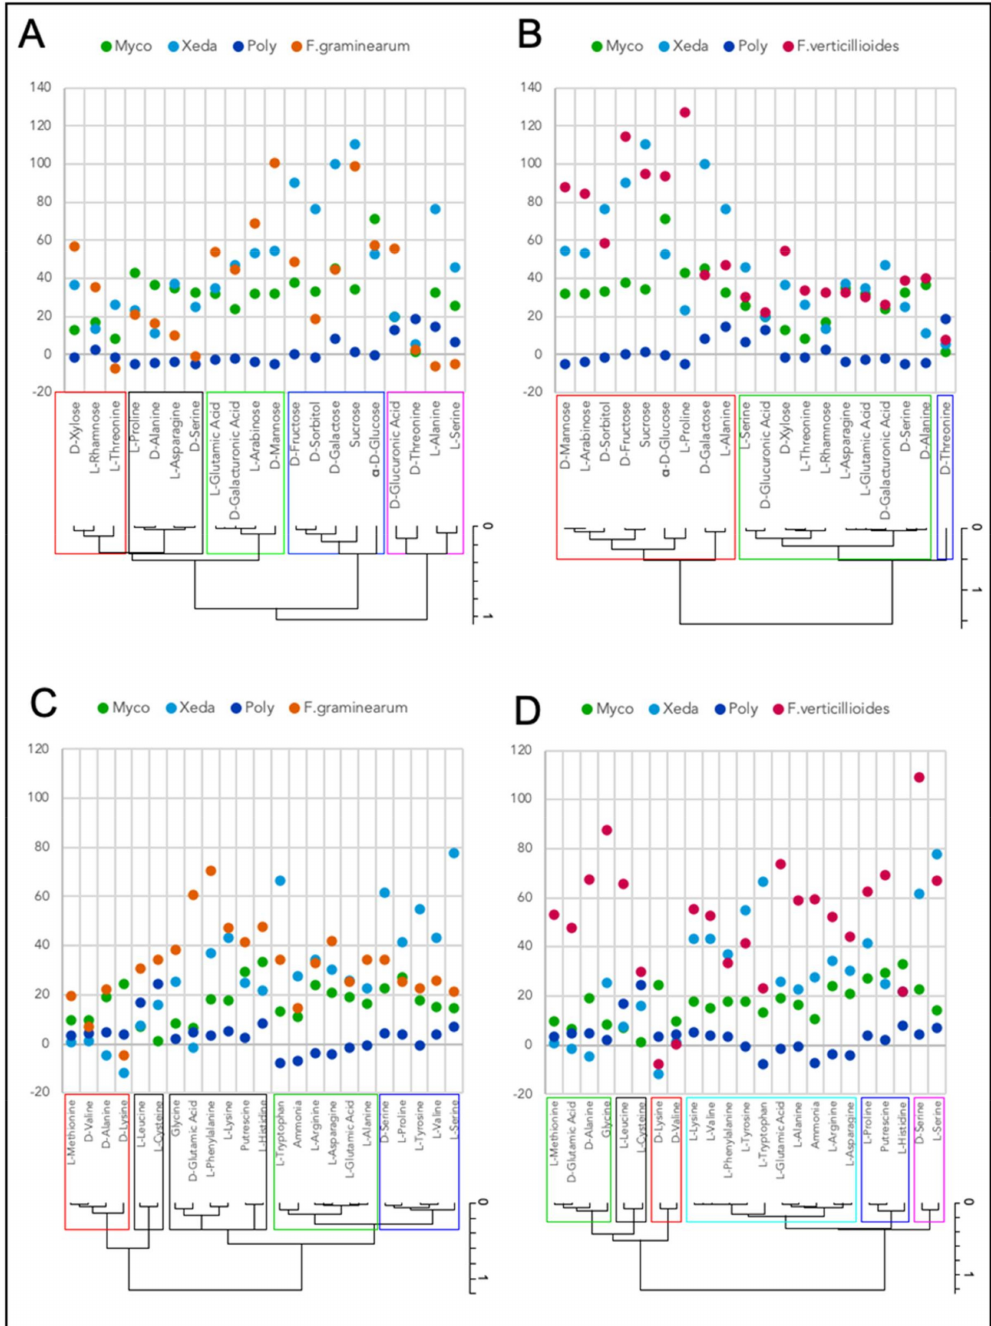
Figure 9. Nutritional profiling of BCAs and Fusaria pathogens for cereal compounds (carbon or nitrogen sources). ( A , B ) F. graminearum and F. verticillioides , respectively, vs. all BCAs (Myco, Xeda and Poly) for carbon compounds; ( C , D ) F. graminearum and F. verticillioides , respectively, vs. all BCAs (Myco, Xeda and Poly) for nitrogen compounds. Both panels show optical density measurements over a 138h time course at 25 ◦ C in phenotype micro-arrays (area under growth curve). Major elements found in cereals (wheat and maize for F. graminearum and F. verticillioides , respectively) are available in literature [30–33]. Hierarchical classification and clustering were done with all microorganisms independently. Myco: Mycostop ® , Xeda: Xedavir ® , Poly: Polyversum ®